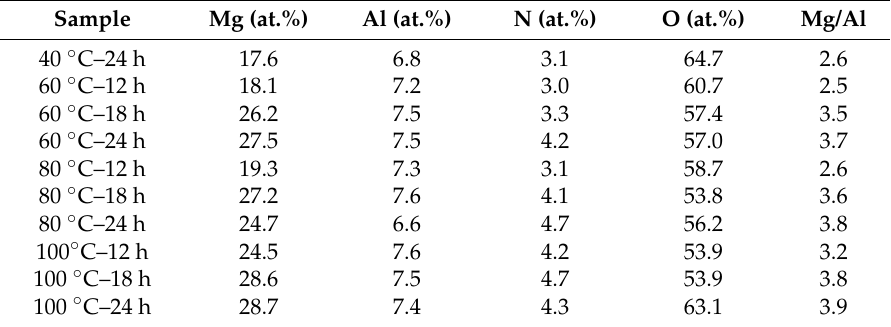
Table 2. EDS study of atomic percentage at various reaction temperature and crystallization times.